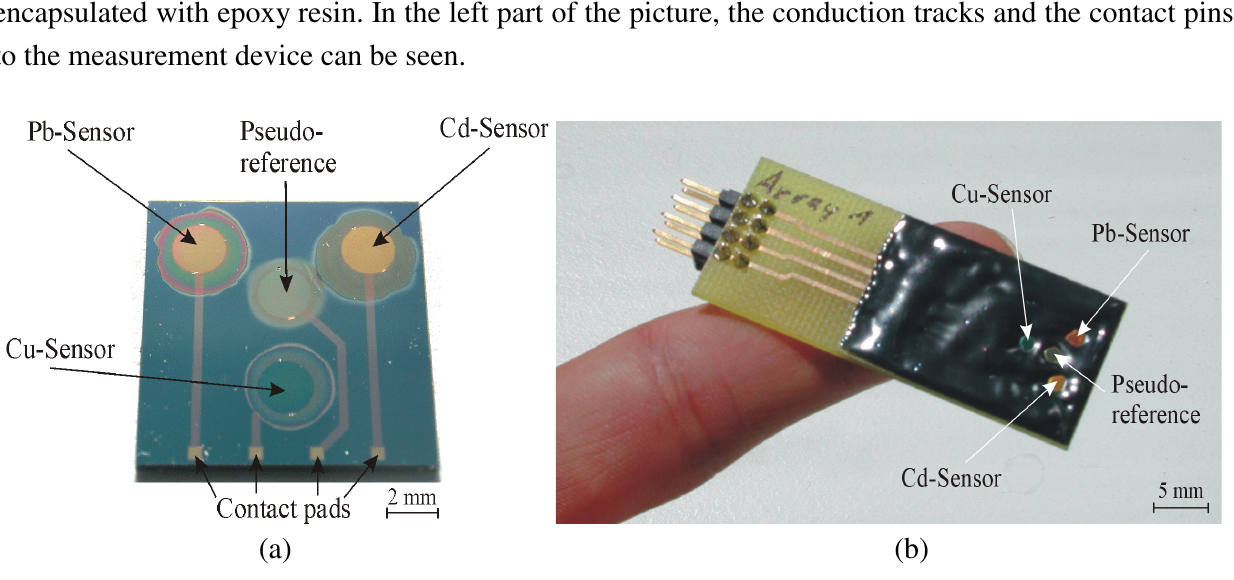
Figure 4. (a) Videomicroscopic picture of the thin-film sensor array after the PLD process. The different chalcogenide glasses onto the electrodes are shown. (b) Picture of the complete thin-film sensor array after wire bonding and